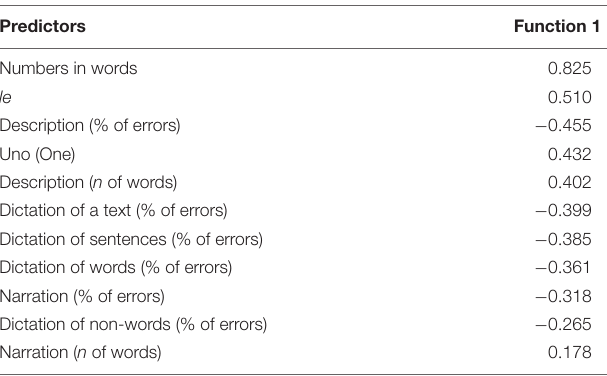
TABLE 4 | Structure matrix of the discriminant